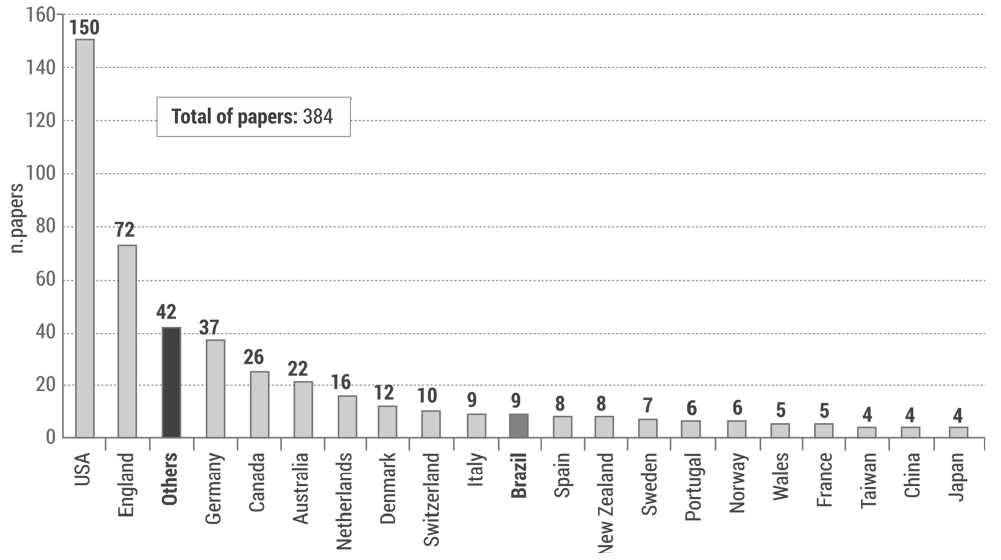
Figure 3 - Papers with keywords [science communication and public] indexed in the Web of Science database